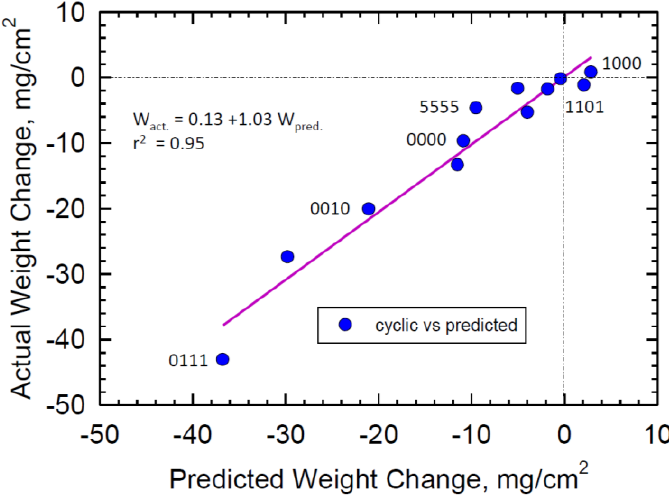
Figure 2. Distribution of actual 1100 °C, 200 h weight changes vs. those calculated from regression fitted Equation (1). Slope is ~1.0 and intercept ~0.1 mg/cm 2